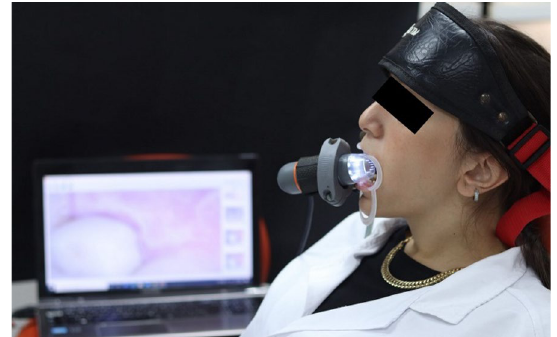
Fig. 7 MHD positioning the microscope to detect the palatal crown margin